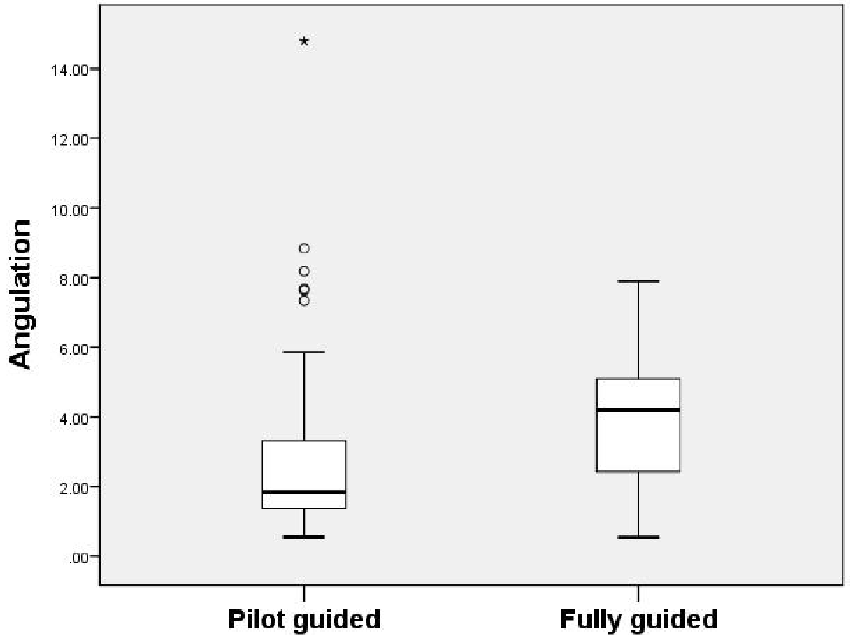
Figure 8. Box plots for deviations—apical area. (Circle and asterisk representing outlier(values that do not fall in the whisker bars) and extreme outlier(values more than three times the height of the boxes), respectively.).